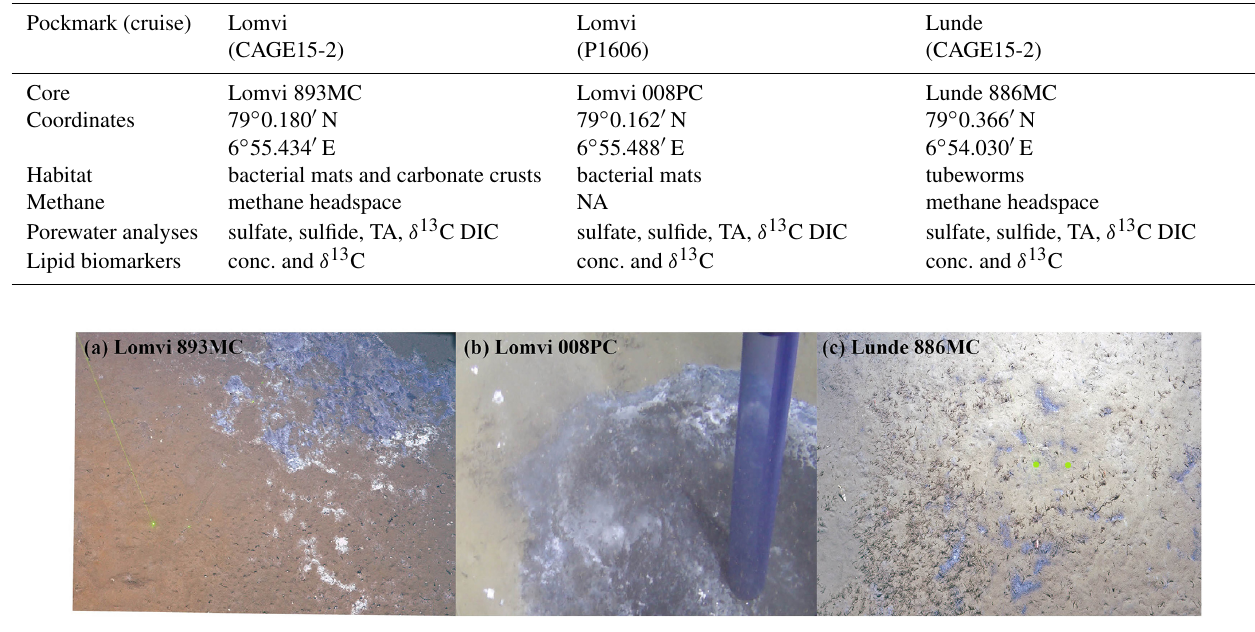
Figure 2. Still images of the seafloor before launching of the multicorer at coring site Lomvi 893MC (a) and coring site Lunde 886MC (c) , as well as during ROV guided push coring at coring site Lomvi 008PC (b) . Coring site Lomvi 893MC (a) and 008PC feature bacterial mats and reduced, black sediments, while the coring site Lunde 886MC (c) is characterized by soft sediments with tubeworms and small patchy bacterial mats. Green laser points (a, c) are 20cm apart and the diameter of the push core (b) is